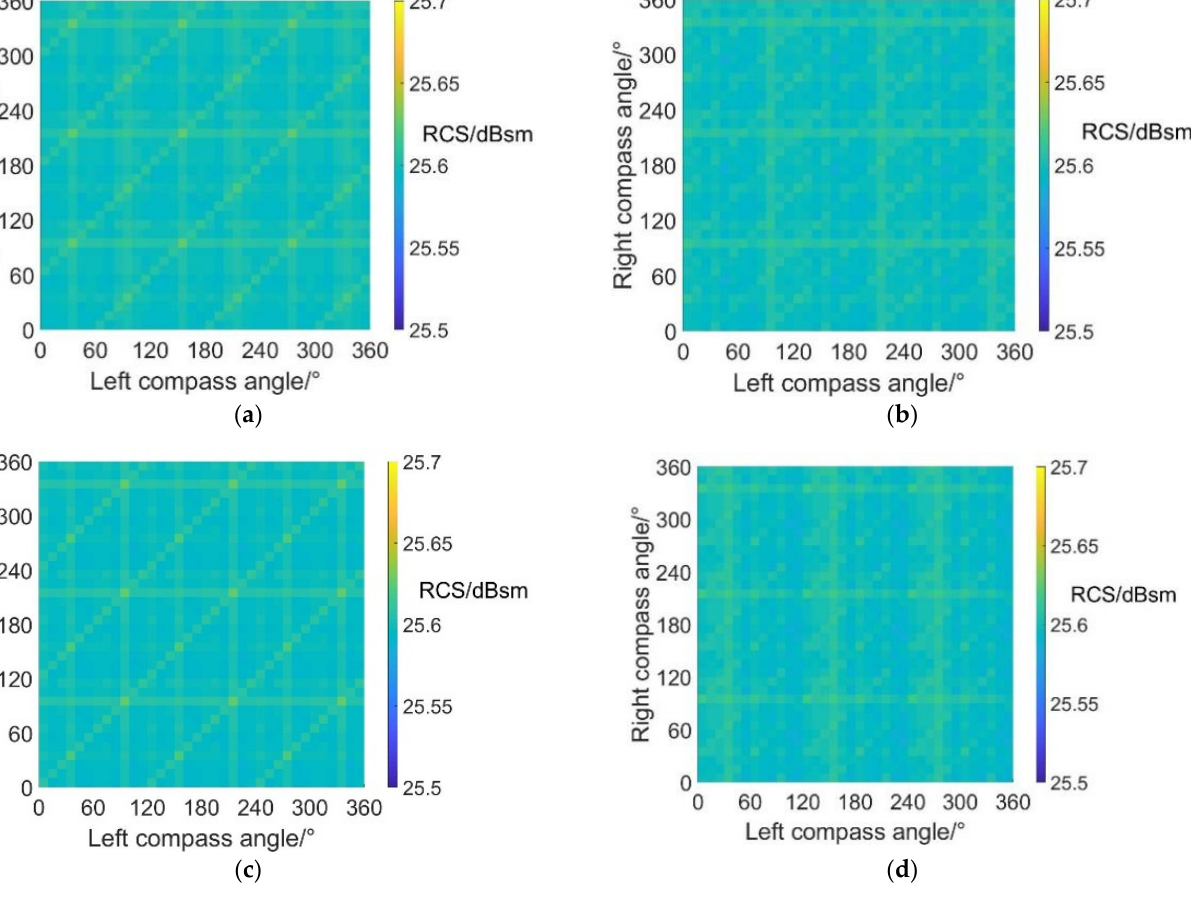
Figure 17. Carpet diagrams of average RCS in helicopter mode at an azimuth angle = 90 ◦ with scissors angle difference = ( a ) 0 ◦ , ( b ) 30 ◦ , ( c ) 60 ◦ , ( d ) 90 ◦ . Table 12. Highest and lowest average RCS values at an azimuth angle = 90 ◦ in helicopter mode. Scissors Angle Difference/